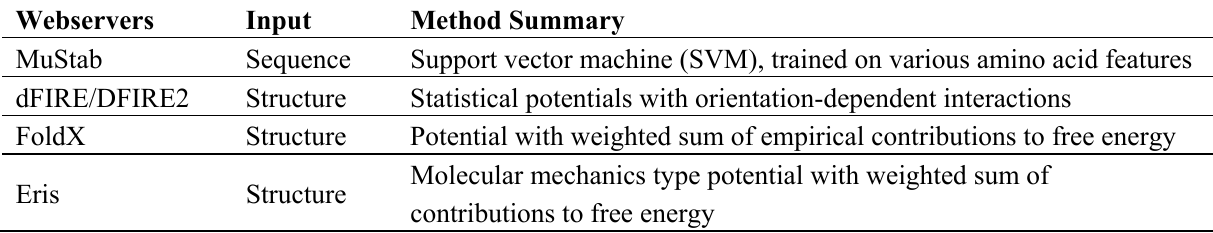
Table 3. Webservers used in the case study along with short description of their